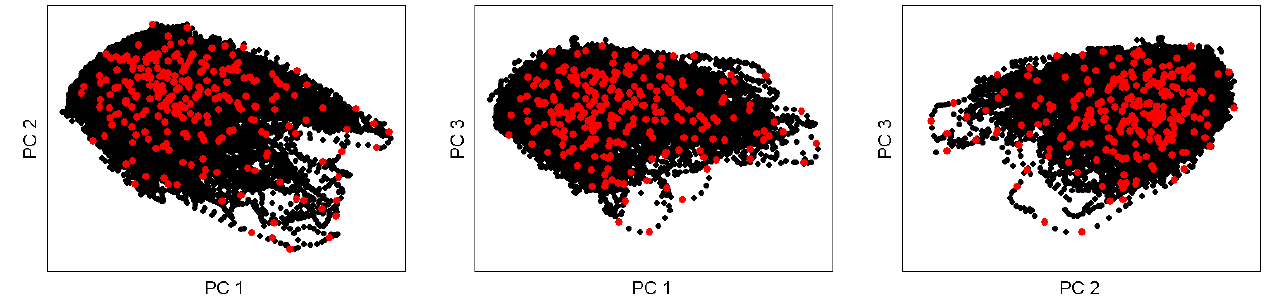
Figure 5. Subset of selected